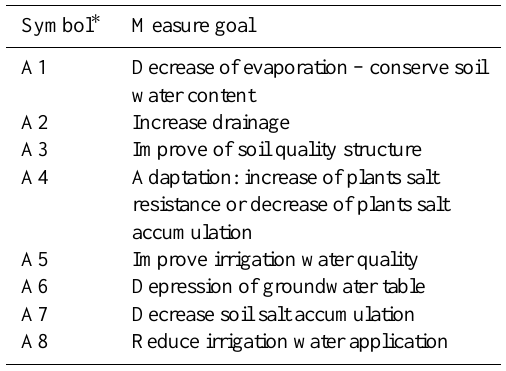
Table 3. Intervention strategies of salinisation amelioration tech-